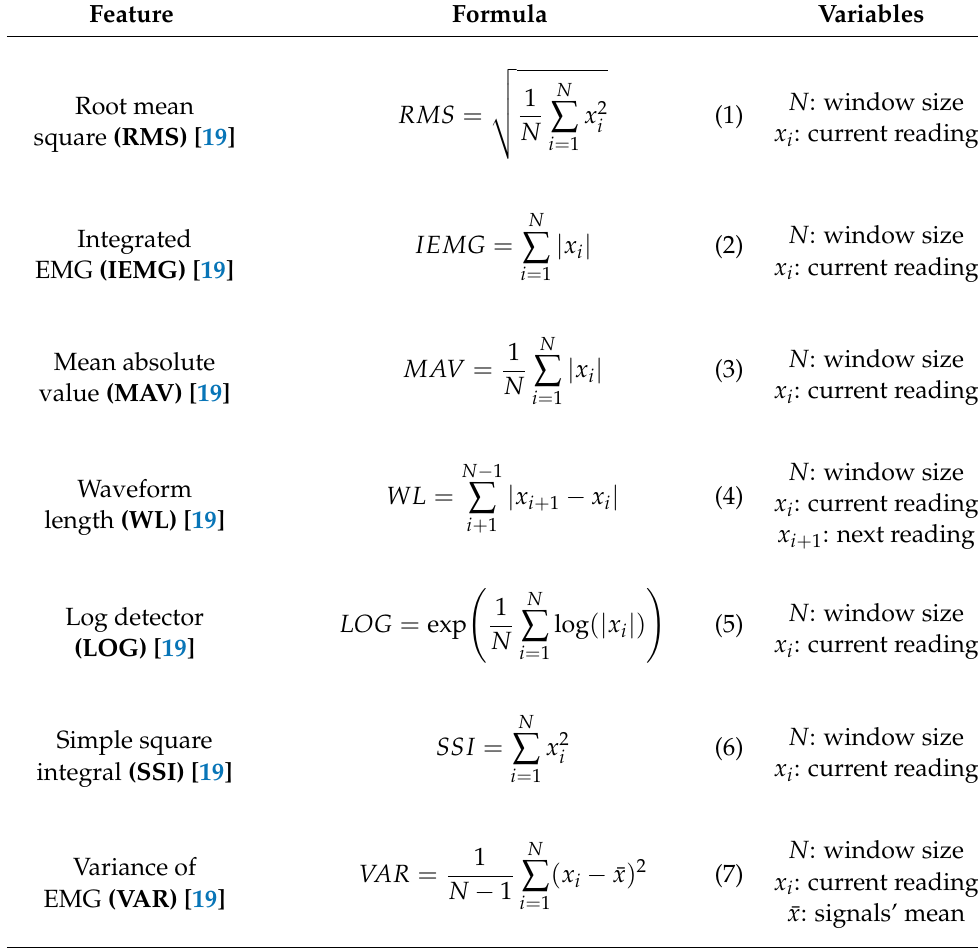
Table 1. Signal features’ equations and